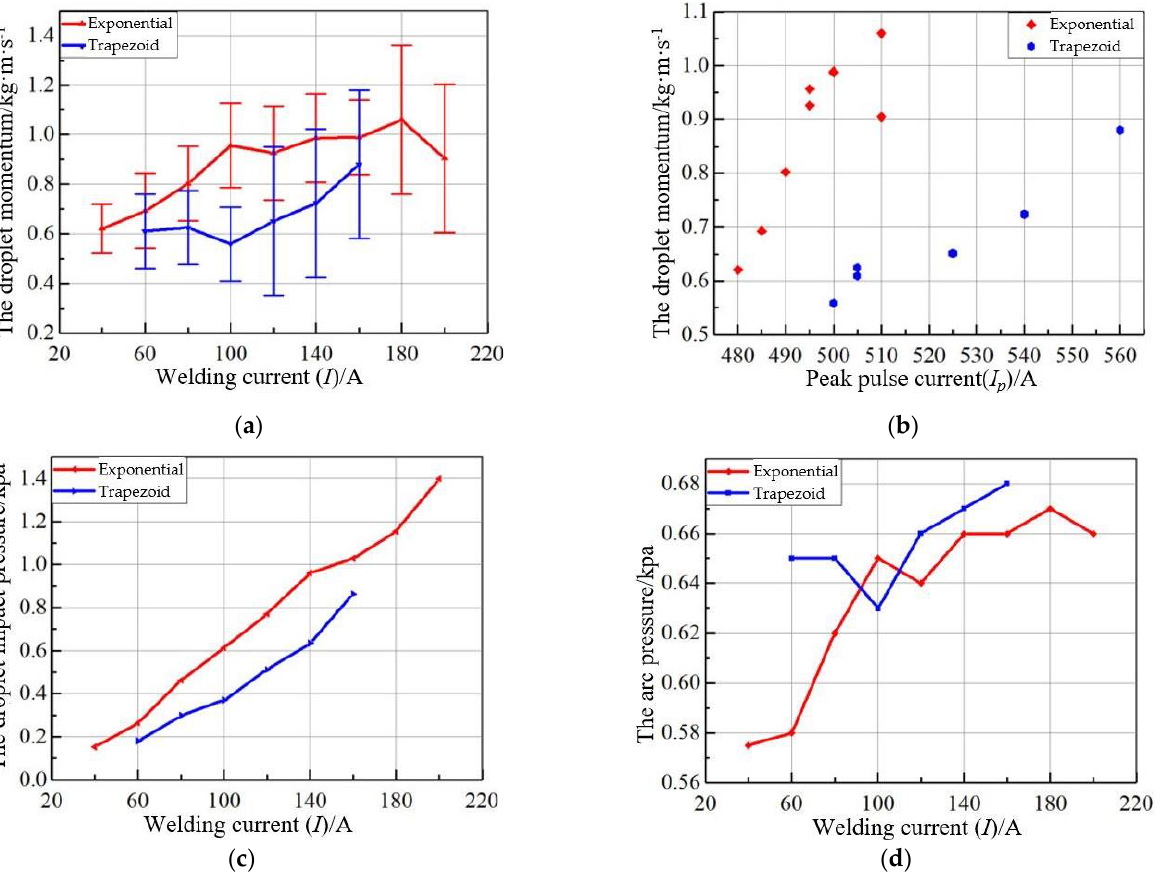
Figure 16. ( a ) Droplet momentum with different welding current; ( b ) droplet momentum with different I p ; ( c ) the droplet impact equivalent pressure with different welding current; ( d ) the arc pressure with different welding current.